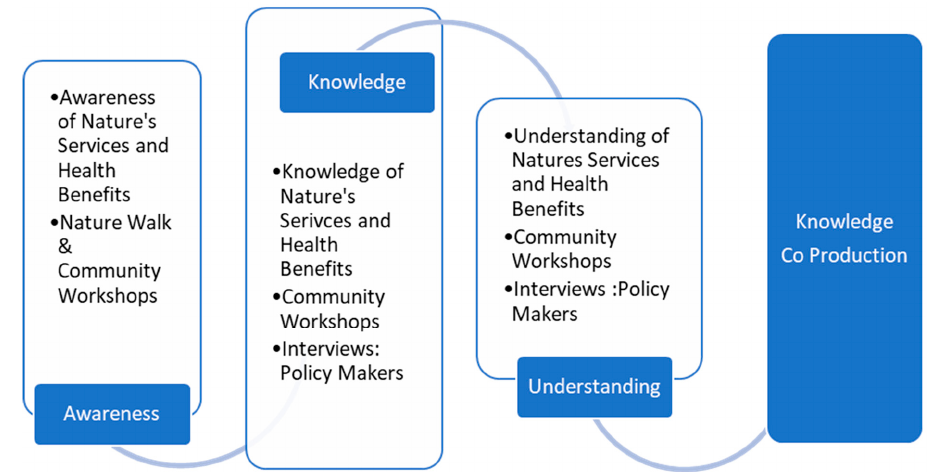
Figure 2. Research Process of Knowledge Co-Production.